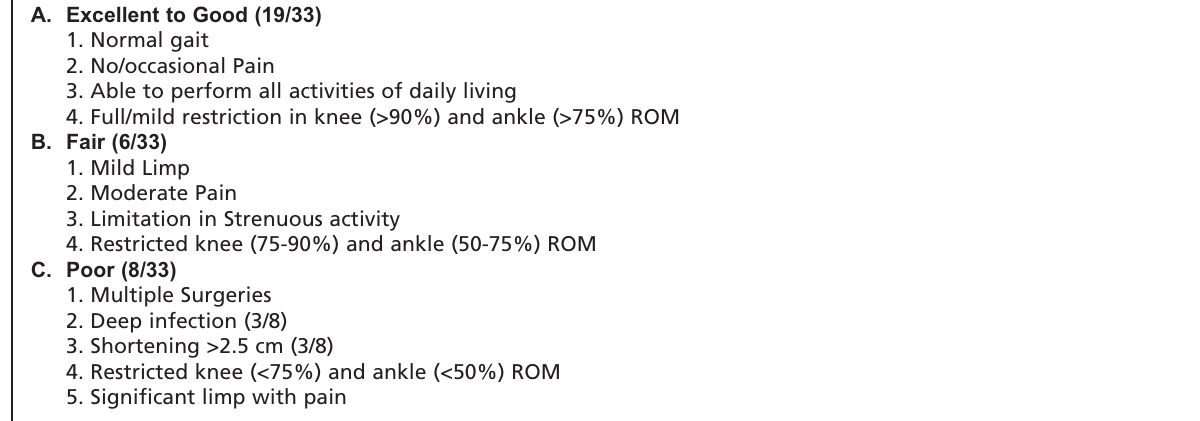
Details of functional outcomes of our study as per Johner and Wruhs Criteria Table III: